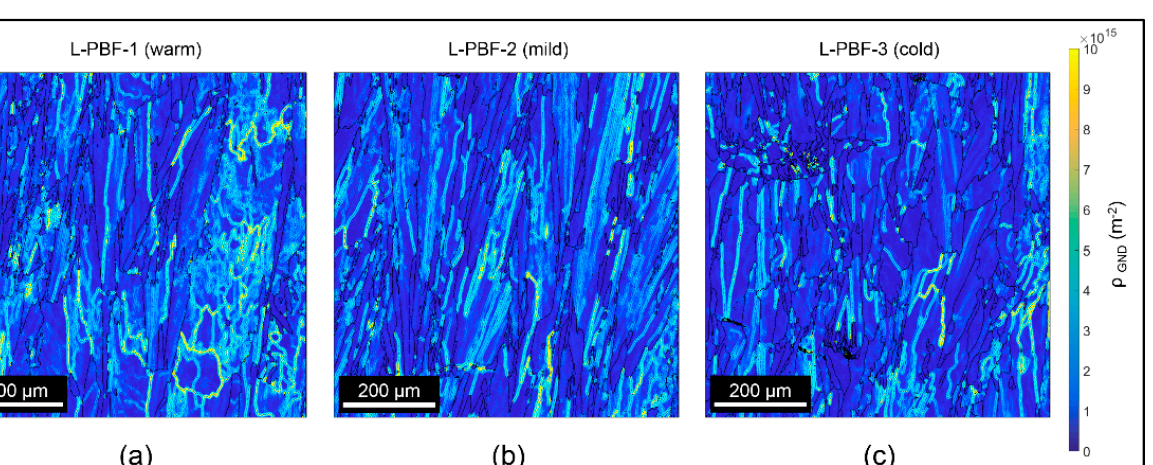
Figure 10 indicates largely heterogeneous GND densities ( ρ GND ) across the microstruc- ture, with strong concentrations along bands corresponding to subgrain boundaries. For each specimen, ten EBSD maps of 750 × 750 µ m 2 each were measured, leading to a total surface area of 5.6 mm 2 . Although the distribution of GND s was strongly heterogeneous in each map, the difference between the mean GND densities obtained for each single map (in a given specimen) appeared to be very small; in the worst case we measured a variation of 12.7% (L-PBF-2 sample). This indicated a good stationarity of the microstructures and that each map can be considered as a representative surface element. The average dislo- cation density in each sample was then estimated by the average over the 10 EBSD maps. We obtained slightly increasing VED values of 2.34 × 10 15 m − 2 , 1.97 × 10 15 m − 2 , and